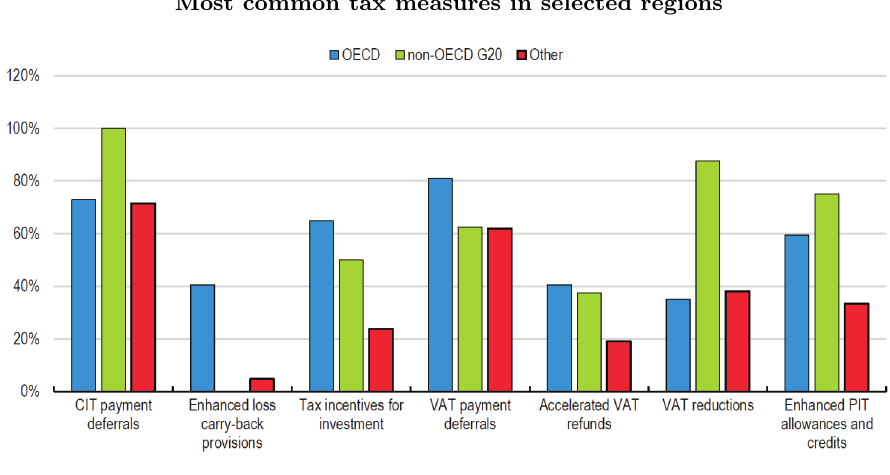
* The three groups of countries consist of 37 OECD countries, eight non-OECD G20 coun- tries and 21 other countries and jurisdictions that are members of the OECD/G20 Inclu- sive